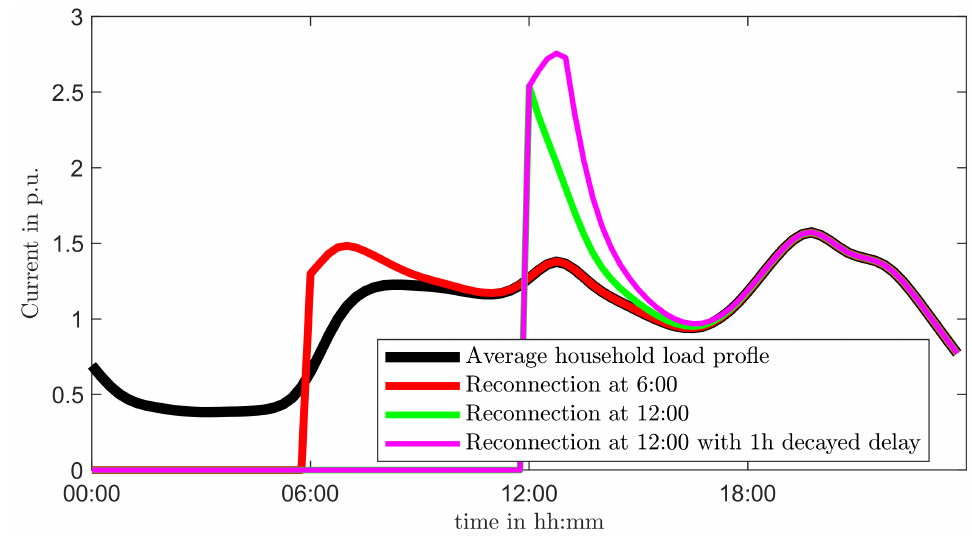
Figure 2. Combination of time-dependent “normal load” and CLPU with a = 1 and τ =